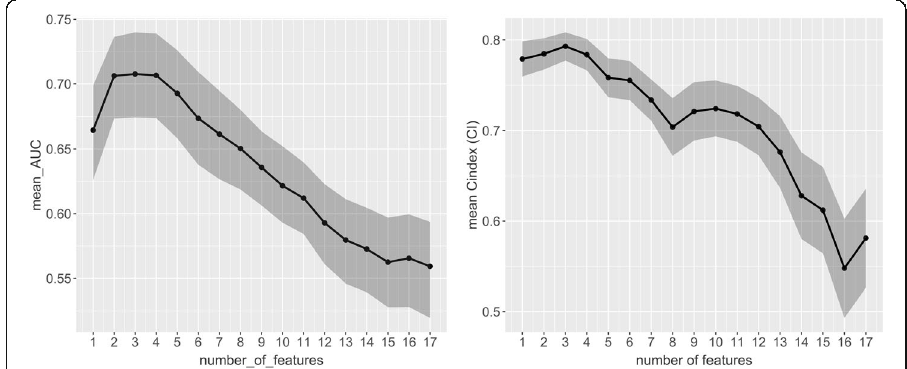
Fig. 3 Radiomics_robust + dose model order determination for OR (left) and progression (right): average AUC/c-index vs. number of top features